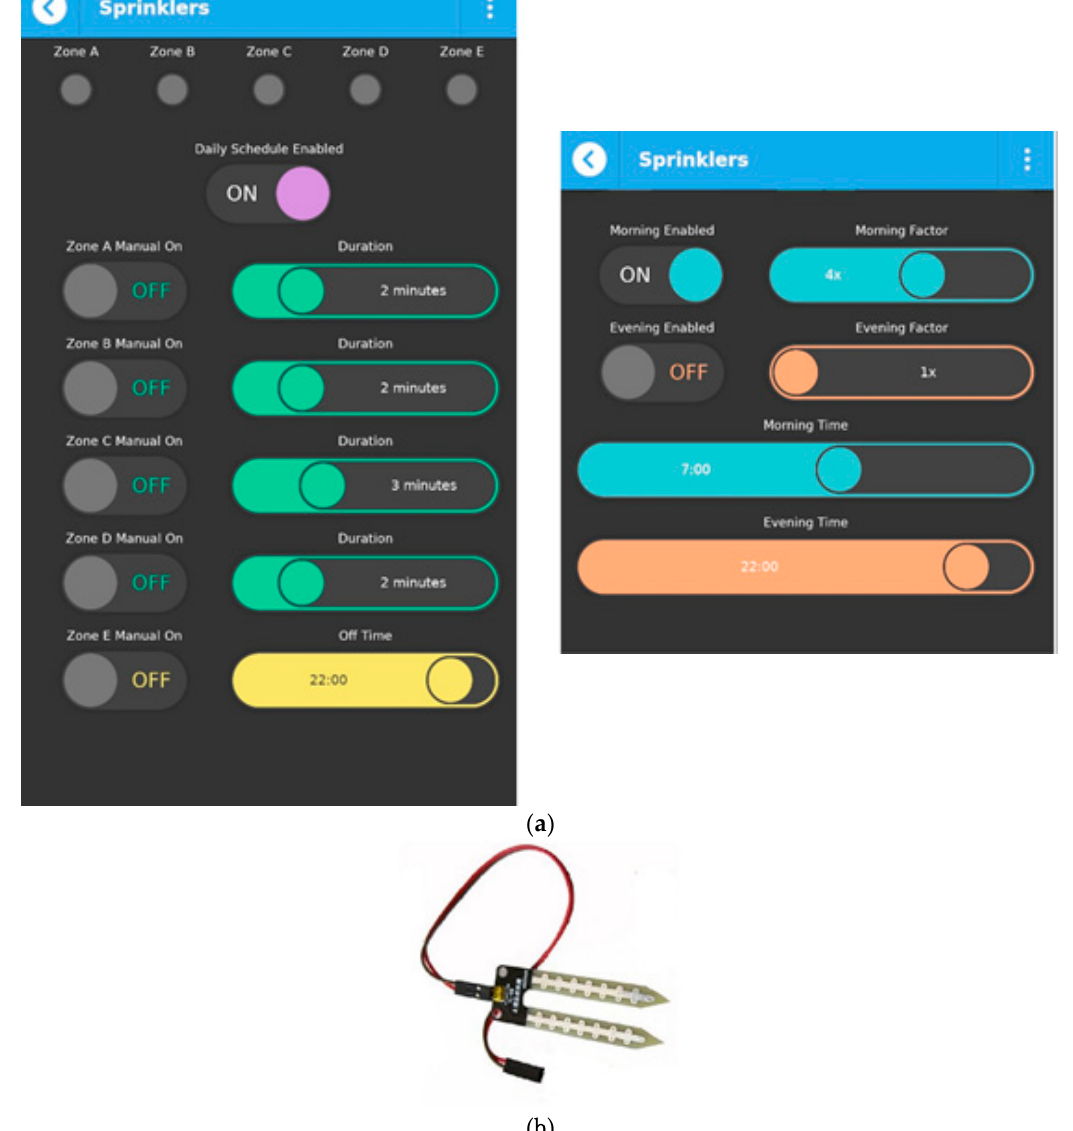
Figure 13. Controlling the irrigation system with qToggle ( a ) and the YL 69 sensor ( b ). In the automatic case, without sensors, the user is able to set schedules, by turning on the Enable schedule button. The adjustments can be made on the last four slides in the app: Morning factor, Evening factor, Morning time, and Evening time. The user is able to select the time in the morning and evening when the irrigation should start but also select the amount of water by adjusting the Morning/Evening factor. A time-controlled sprinklers system not only eliminates the chore of hand watering but also saves water, time, energy, and of course money. The sensors and actuators used for the presented case study, along with their main characteristics are shown in Table 3. Of course, in the arhitecture of qToggle, any kind of sensor or actuator can be used.